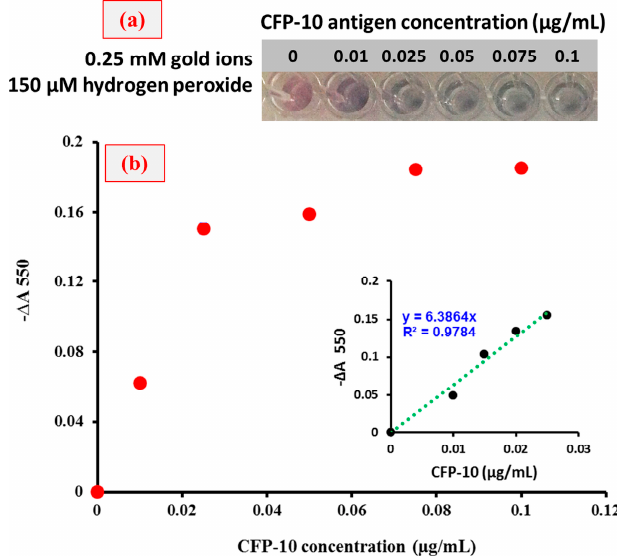
Figure 7. Dose-dependent binding assays by using catalase-assisted plasmonic ELISA for CFP-10 detection. ( a ) Naked-eye detection of CFP-10 using plasmonic ELISA and ( b ) the signal ( −∆ A 550) is expressed as the decrease in absorbance with respect to the blank monitored at 550 nm.